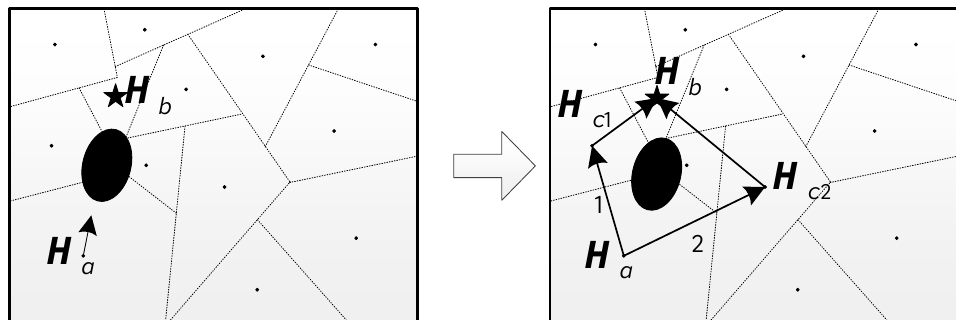
Figure 3. Diagram of hub configurations connection.